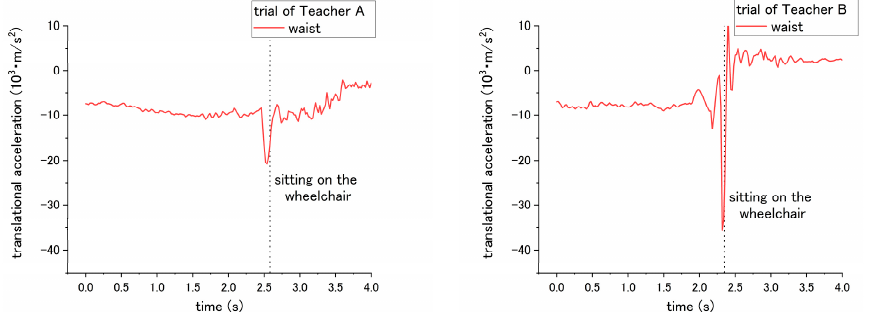
Figure 9. Translational acceleration of patient’s chest during step No. 15 through incorrect way conducted at step No. 14.